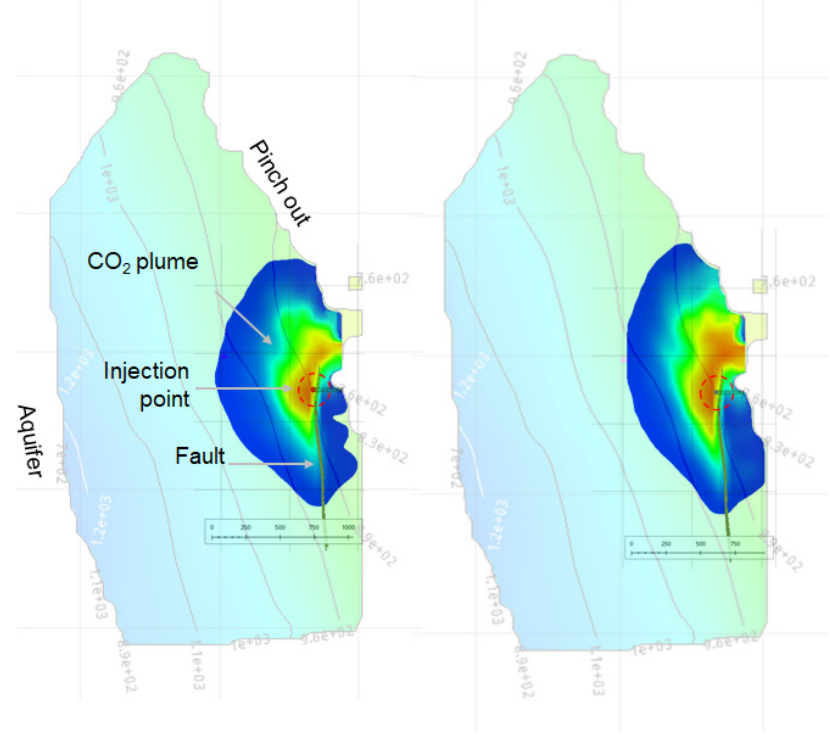
Figure 15. CO 2 plume extensions after one year of net-time injection for the cases of continuous ( left ) and periodic ( right ) injection.